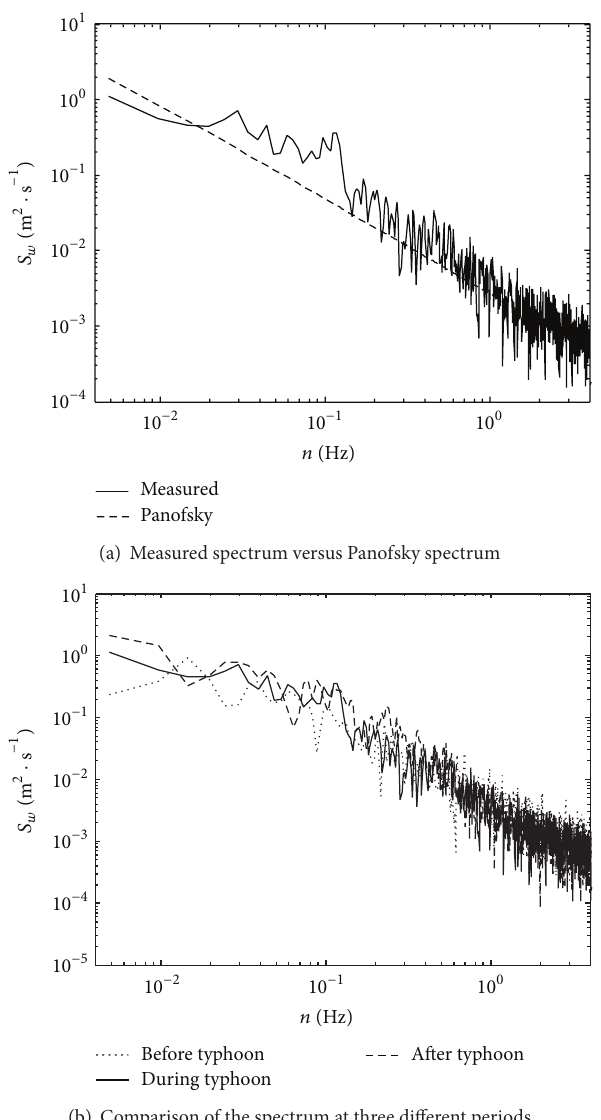
Figure 13: Analysis of the vertical turbulence power spectrum of Typhoon